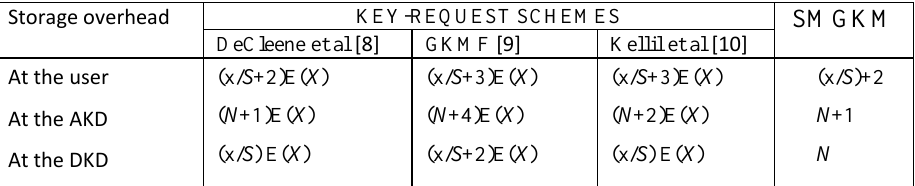
Table 2. Comparison of storage complexity during high